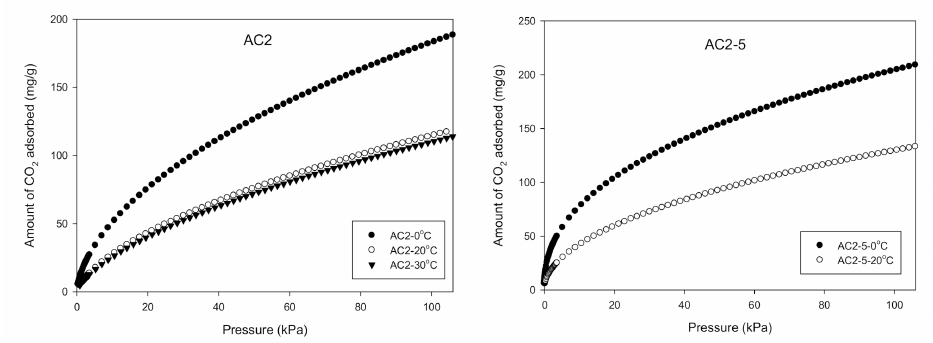
Figure 10. Effect of temperature on CO 2 adsorption of AC2 and AC2-5 samples.